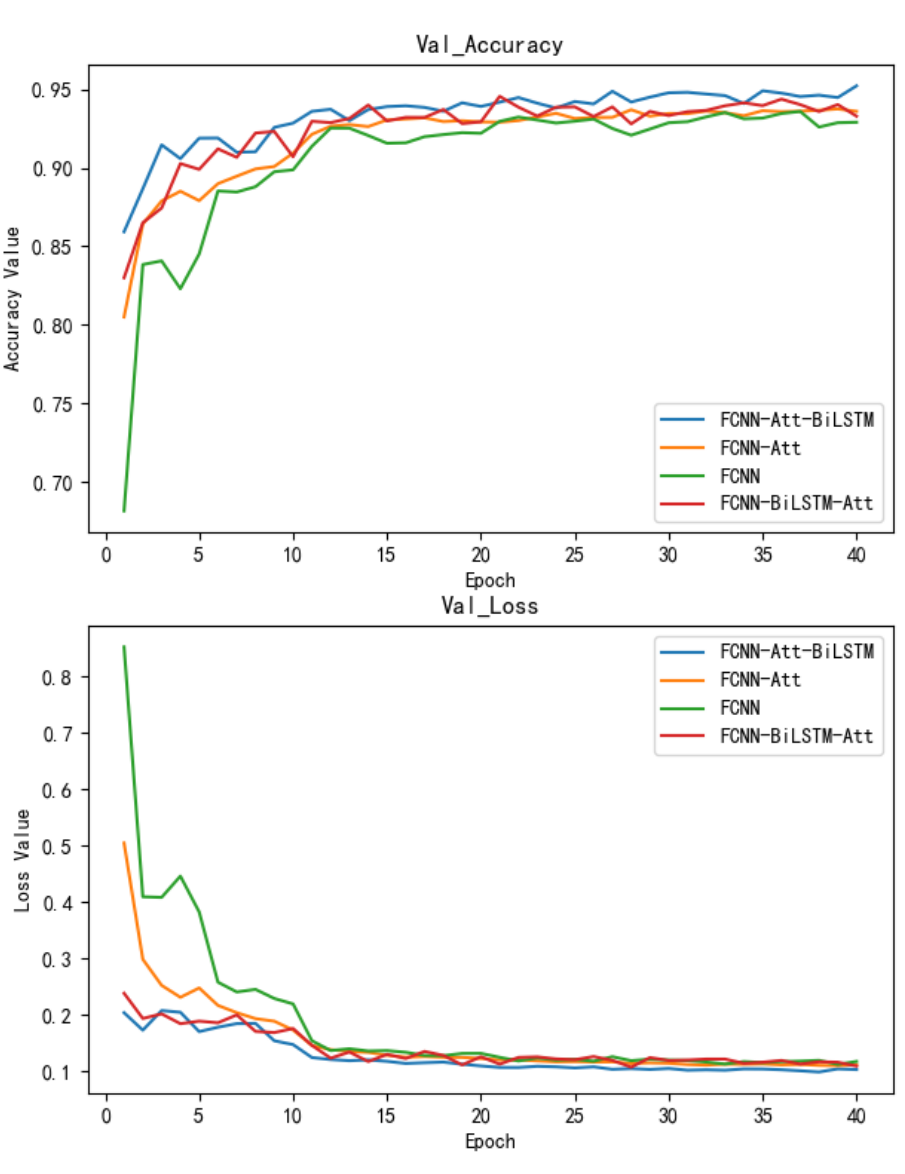
Figure 6. Training history of the validation set on the source